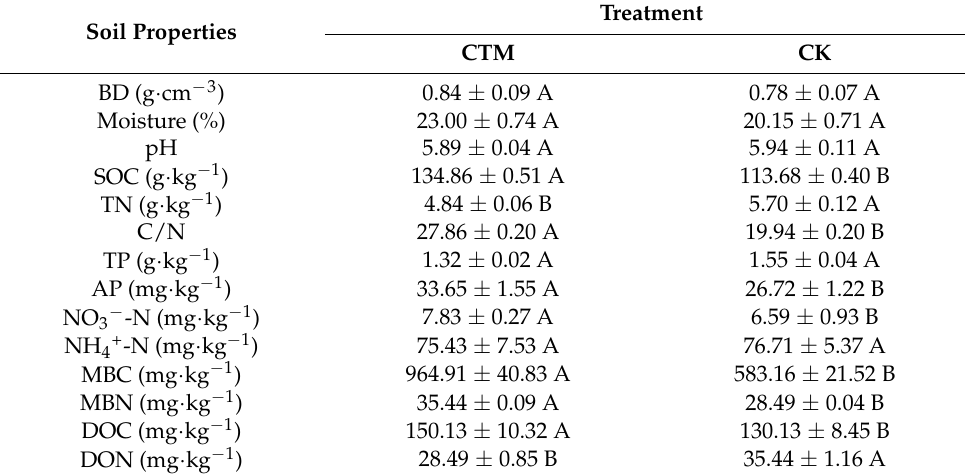
Table 2. Soil physicochemical properties in a L. gmelinii